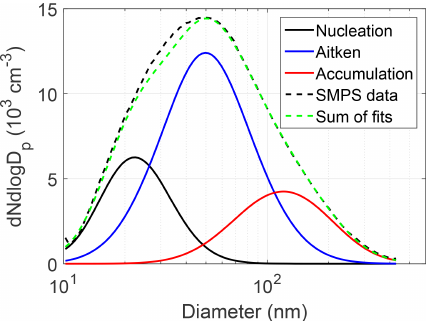
Figure 5. Average particle number size distribution for measured and lognormal fits for nucleation, Aitken, and accumulation modes. Mean geometric diameter (and geometric SD) of the modes are 12.6nm (1.2nm), 30.7nm (1.3nm), and 83.8nm (1.3nm). The lo- cal maximum of the number distribution (mode diameter) is at 22.5nm for nucleation, at 49.6nm for Aitken, and at 121.9nm for accumulation modes. The average ± SD for particle number con- centration is 12500 ± 7200cm − 3 .